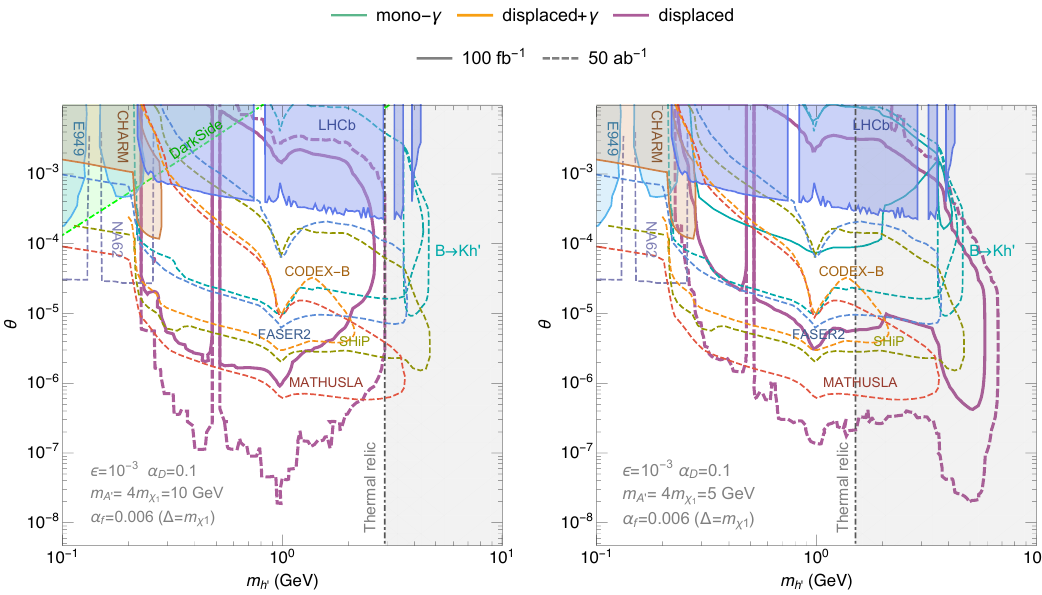
Figure 4 . Expected sensitivities of the different searches at Belle II in the θ − m h 0 parameter plane for integrated luminosities of 100 fb − 1 (solid lines) and 50 ab − 1 (dashed lines). We also show current limits from DarkSide [77], LHCb, CHARM and E949 (taken from [49]) as well as a number of expected sensitivities of proposed future searches as shown in [49] and